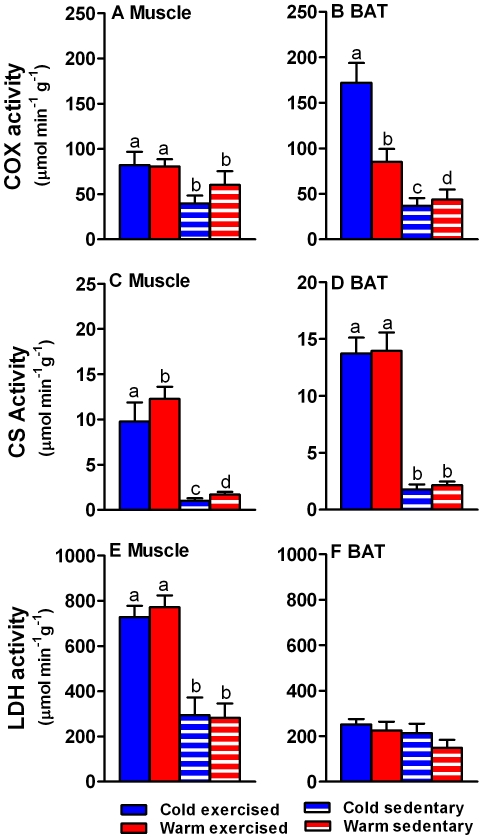
Enzyme activities in skeletal muscle and BAT from cold and warm acclimated sedentary and exercised rats.Activity (µmol substrate converted g−1 wet tissue; mean ± s.e.m) of cytochrome c oxidase (COX; A and B), citrate synthase (CS; C and D) and lactate dehydrogenase (LDH; E and F) of cold exercised (blue bars), warm exercised (red bars), cold sedentary (blue hatched bars) and warm sedentary (red hatched bars) rat skeletal muscle and brown adipose tissue (BAT). Exercise had a significant effect on all enzyme activities, but the effect of cold exposure alone was limited. Letters above each column indicate significant differences.